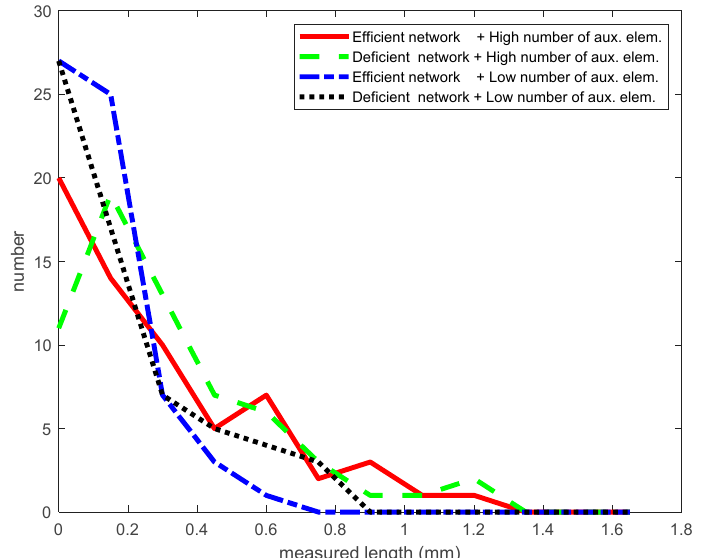
Figure 7. Distribution of the observed length measurement errors without showing their dependency on the measured distance.